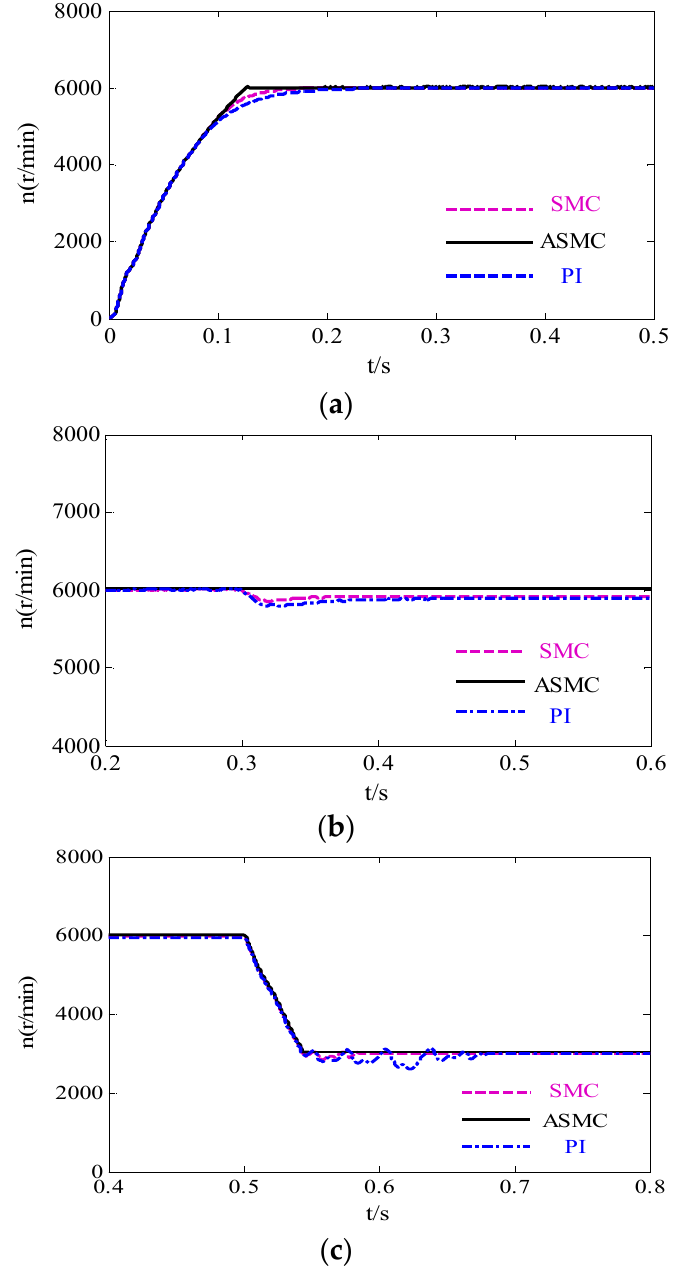
Figure 4. Waveforms of the speed dynamic response (6000 r/min): ( a ) the response of speed under no ‐ load; ( b ) the response of speed under the sudden load (5 N ∙ m); ( c ) the response of speed mutation under the torque disturbance (from 6000 r/min to 3000 r/min).